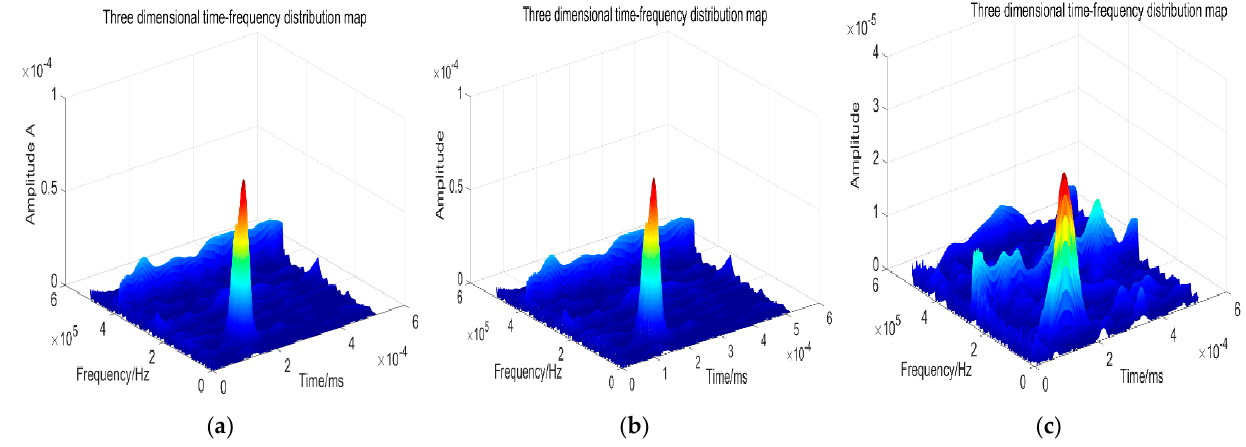
Figure 10. Target sound emission signal three-dimensional time frequency analysis. ( a ) First three-